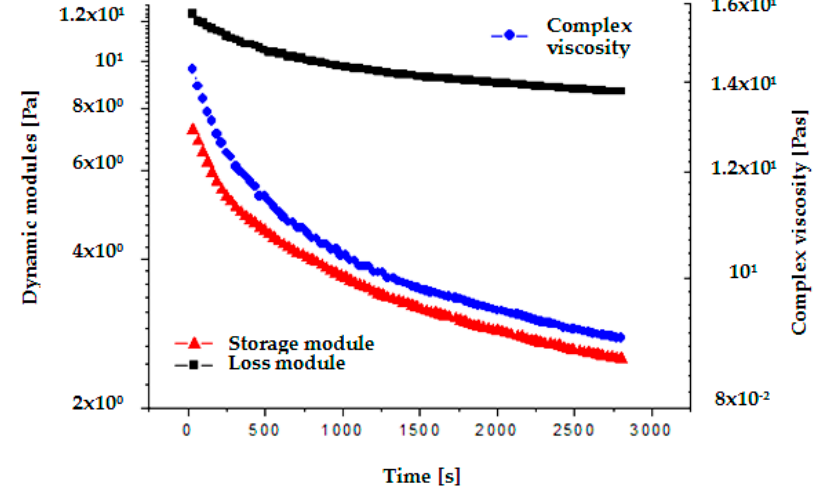
Figure 12. Storage module, loss module and complex viscosity for EM_4c.